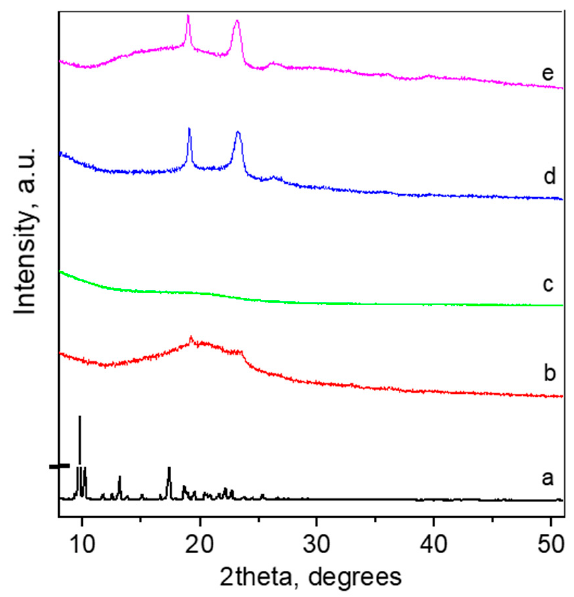
Figure 3. XRD pattern of pure cannabidiol (a), empty Pluronic P123 micelles (b), CBD-loaded Pluronic P123 micelles (c), empty (d), and CBD-loaded mixed Pluronic P123/F127 micelles (e).